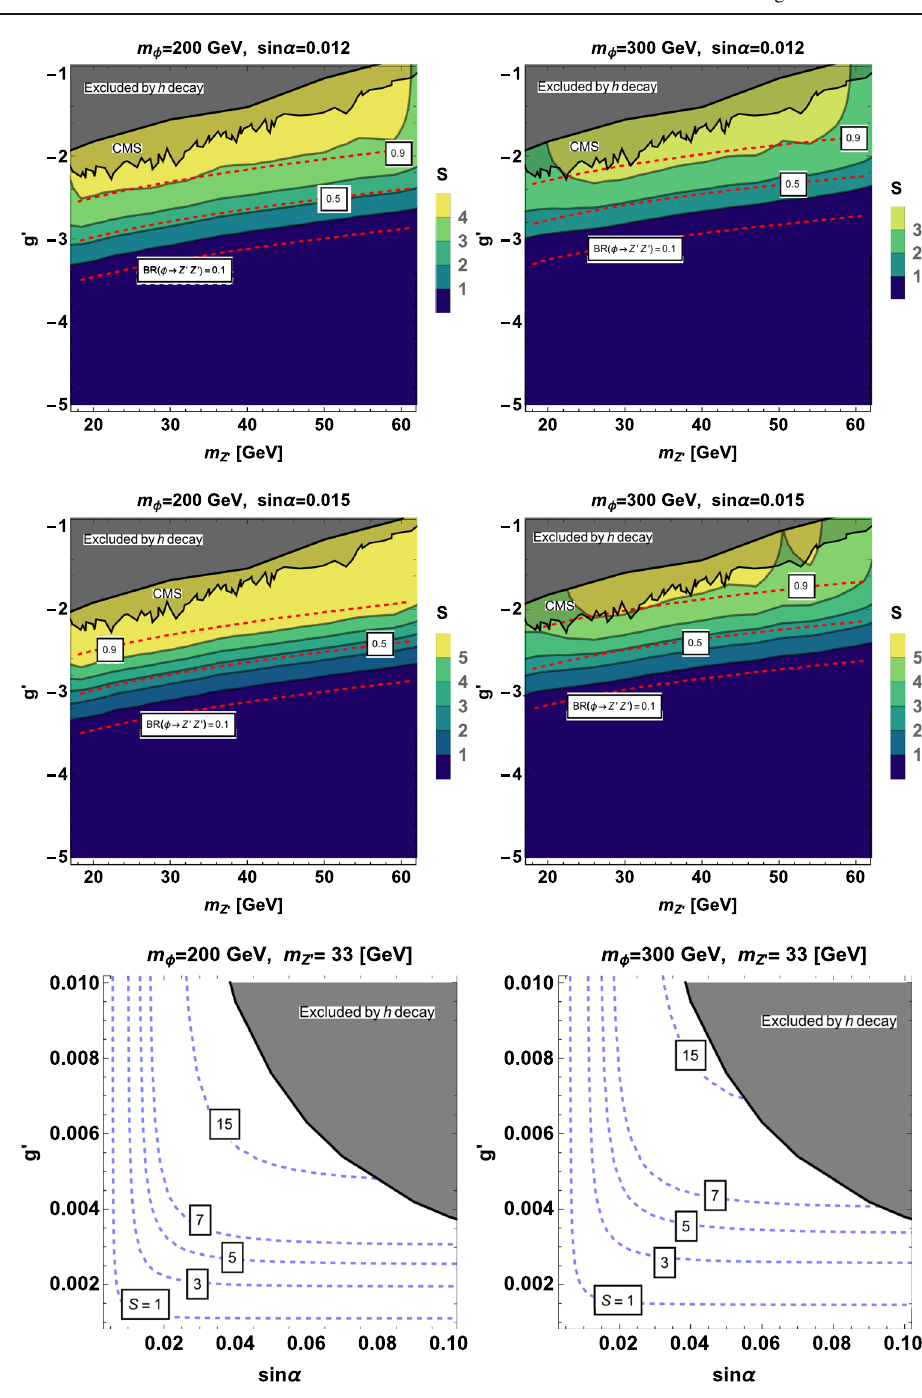
Fig. 8 Significance on m Z (cid:2) – g (cid:2) plane where red dashed lines are for BR (φ → Z (cid:2) Z (cid:2) ) and its values are indicated on the lines